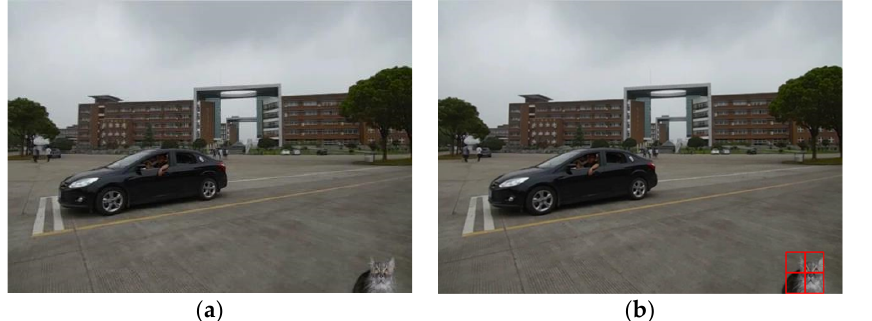
Figure 7. One frame of SAM_3.mov. ( a ) Video frame; ( b ) detection result. The region in the red box is the splicing object.